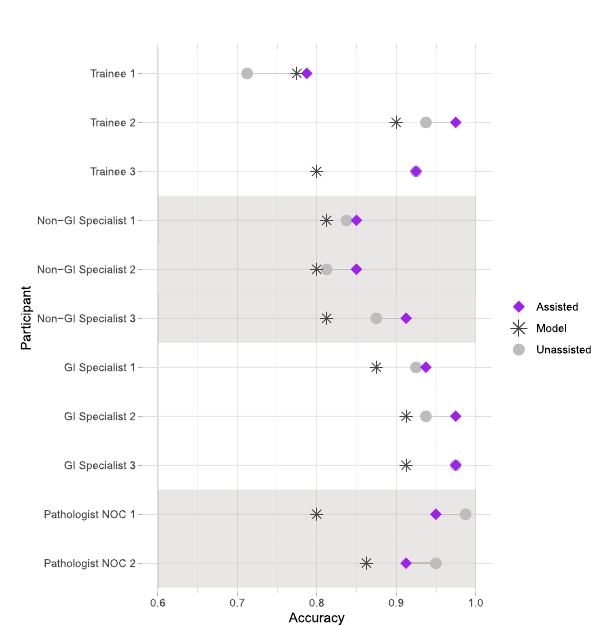
Fig. 4 Impact of assistance on individual pathologist diagnostic performance. The average diagnostic accuracy (across the set of 80 experiment WSI) for each pathologist is plotted as follows: gray circle (unassisted) = accuracy of the unassisted pathologist, star (model) = accuracy of the model alone (based on pathologist selected input patches), purple diamond (assisted) = accuracy of the pathologist with model